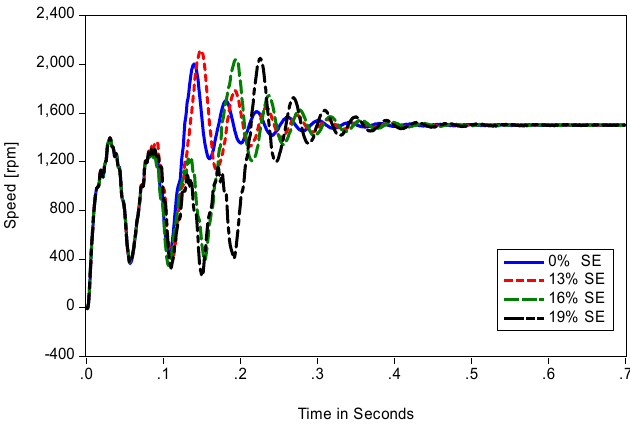
Figure 13. Speed under different values of SE.